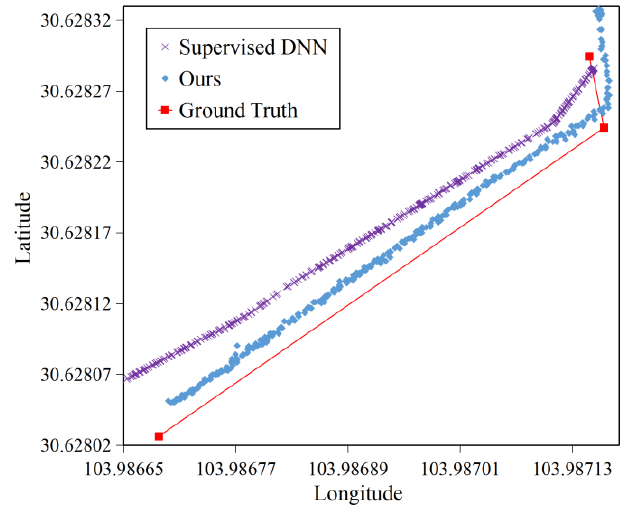
Figure 16. Location distribution when GNSS is denied in Scenario 3.